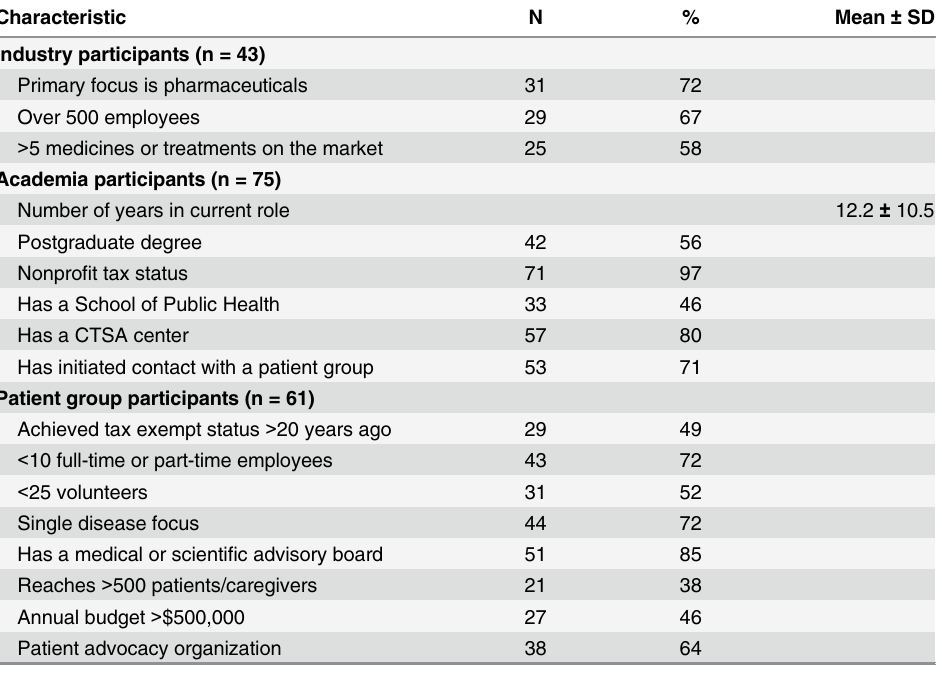
Table 1. Characteristics of the Study Sample (n =